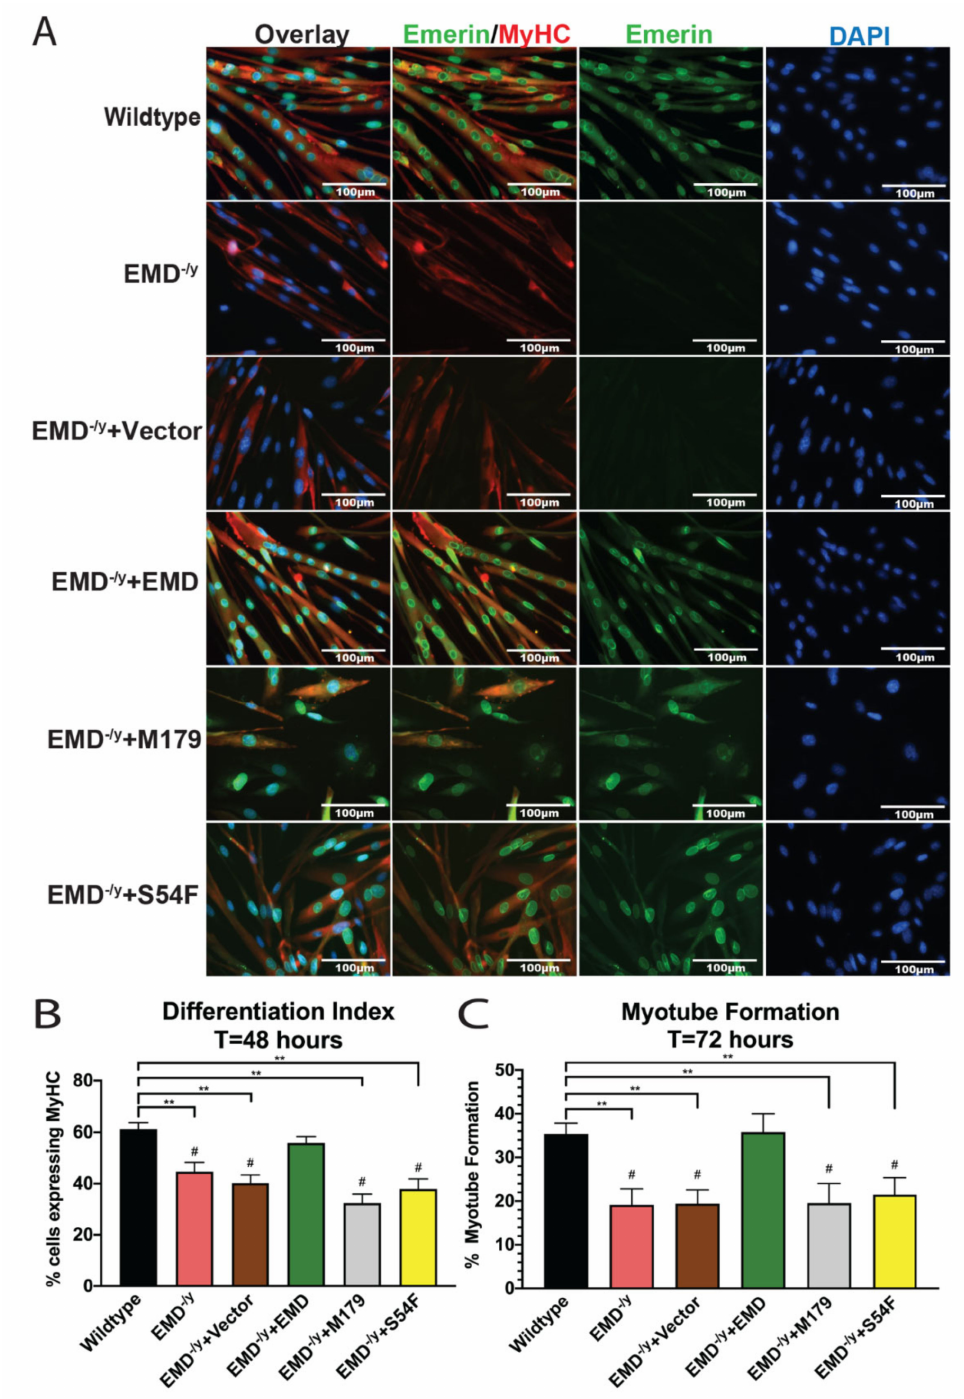
Figure 3. Emerin mutant myogenic progenitors M179 and S54F fail to form mature myotubes. ( A ) Immunofluorescence images at 72 h post di ff erentiation induction. Scale bar: 100 µ m. ( B ) The di ff erentiation index at 48 h post di ff erentiation induction. Emerin mutant progenitors M179 and S54F fail to rescue the di ff erentiation index. ( C ) Myotube formation at 72 h after di ff erentiation induction. Emerin mutant progenitors M179 and S54F fail to form mature myotubes after 72 h. ** p < 0.02; # p < 0.05 in comparison to +